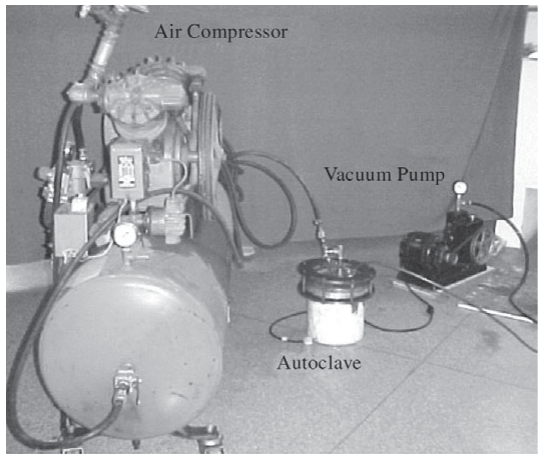
Figure 2. System used to impregnate the